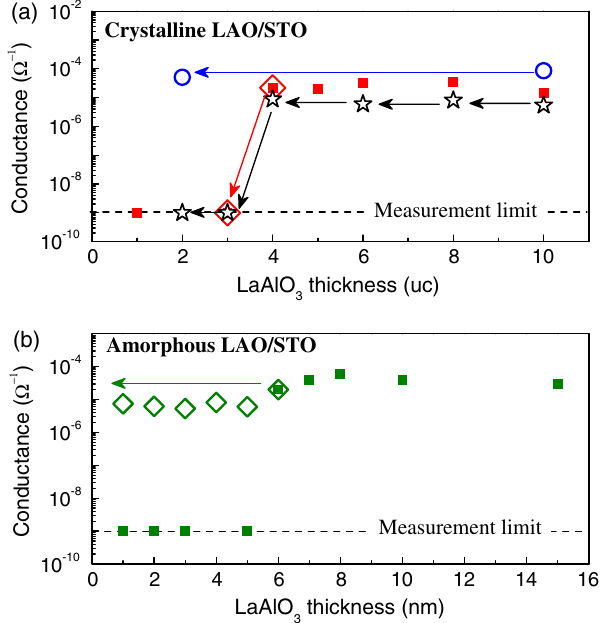
FIG. 5. Ar-milling effect. (a) Thickness dependence (red solid squares) of room-temperature conductance of oxygen-annealed crystalline LAO/STO heterostructures fabricated at 10 (cid:2) 3 Torr and 750 (cid:1) C , showing a critical thickness of 4 uc. The red hollow diamonds denote that the conductivity of the 4-uc sample dis- appears after the removal of the top 1-uc LAO by Ar milling. Moreover, the blue hollow circles represent the conductance of an unannealed 10-uc crystalline LAO/STO heterostructure and after the removal of the top 8-uc LAO by Ar milling. The black hollow stars represent the conductance of another oxygen- annealed 10-uc crystalline LAO/STO sample after step-by-step Ar milling. (b) Thickness dependence (green solid squares) of room-temperature conductance of amorphous LAO/STO hetero- structures fabricated at 10 (cid:2) 3 Torr , showing a critical thickness of 6 nm. The green hollow diamonds represent the conductivity of the 6-nm sample that remains after the removal of the top LAO layer 1 nm at a time by Ar milling. All the arrows represent the Ar-milling